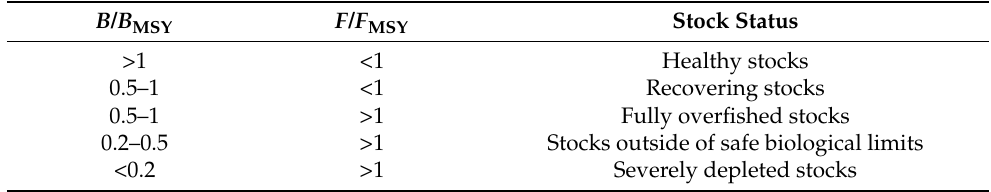
Table 2. Definition of fish stock status for fisheries management, based on B / B MSY and F / F MSY in the final year of a time series (from Froese et al.,